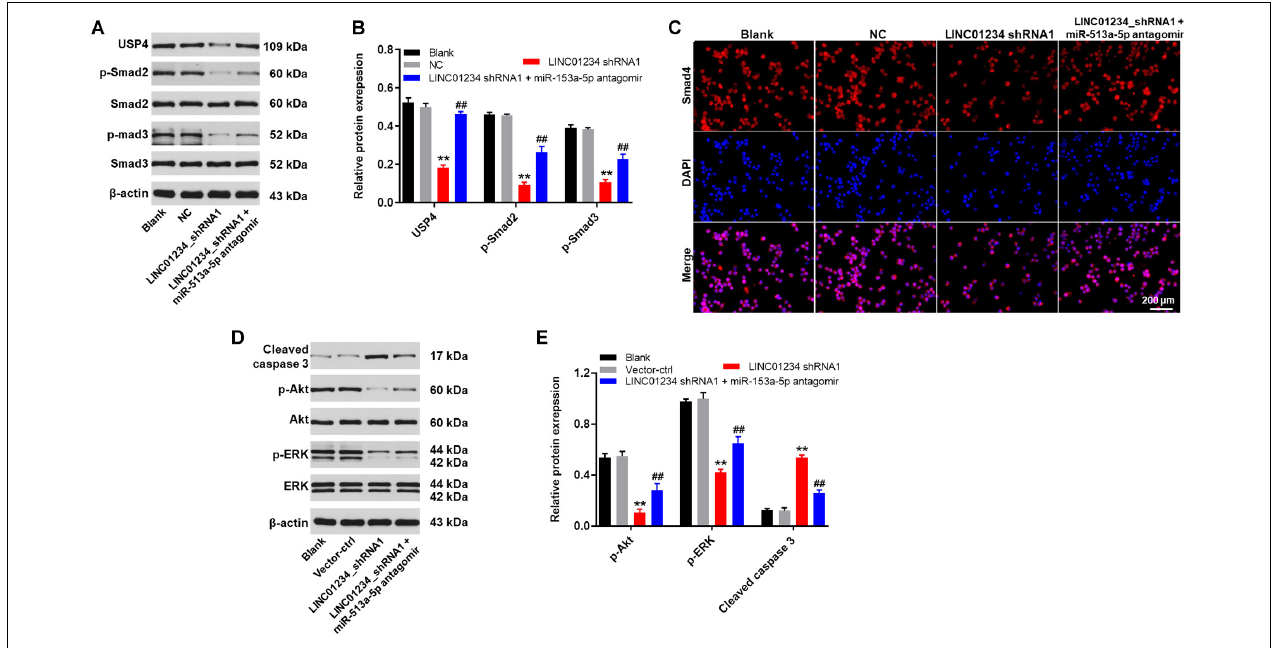
FIGURE 5 | Downregulation of LINC01234 notably inhibited the tumorigenesis of liver cancer via mediation of miR-513a-5p/USP4/TGF- β 1 axis. (A) The protein expressions of USP4, Smad2, Smad3, p-Smad2 and p-Smad3 in Huh-7 cells were detected by western blot. (B) The relative protein expressions were quantified by normalizing to β -actin. (C) The location of Smad4 was explored by immunofluorescence staining. Red indicates Smad4 fluorescence. Blue indicates DAPI fluorescence. (D) The protein expressions of Akt, p-Akt, cleaved caspase 3, ERK and p-ERK in Huh-7 cells were measured by western blot. (E) The relative protein expressions were quantified by normalizing to β -actin. ** P < 0.01 compared to control. ## P < 0.01 compared to LINC01234